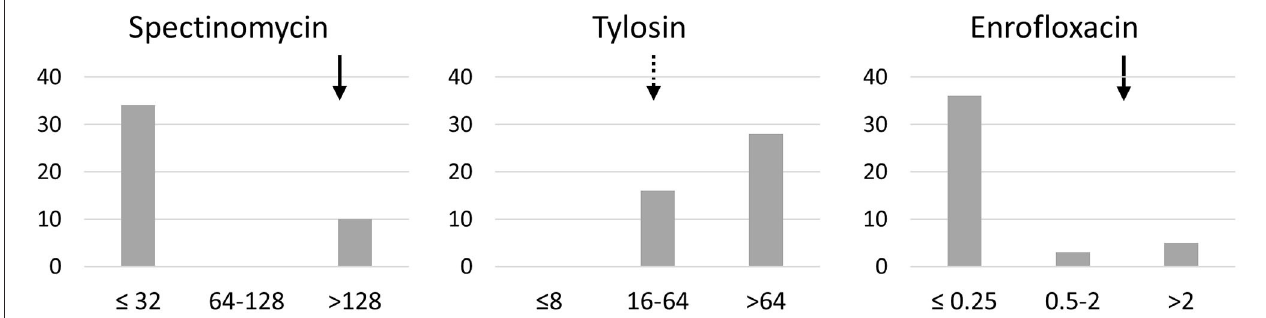
FIGURE 3 | Distribution of the MIC profiles of spectinomycin, tylosin and enrofloxacin for 44 clones of M. bovis. X-axis, MICs classes; y-axis, number of clones. Arrows indicate the clinical breakpoints for resistance for Pasteurellaceae , i.e., spectinomycin ≥ 128 µ g/mL, enrofloxacin ≥ 2 µ g/mL, and tylosin ≥ 32 µ g/mL threshold of tilmicosin used (dashed